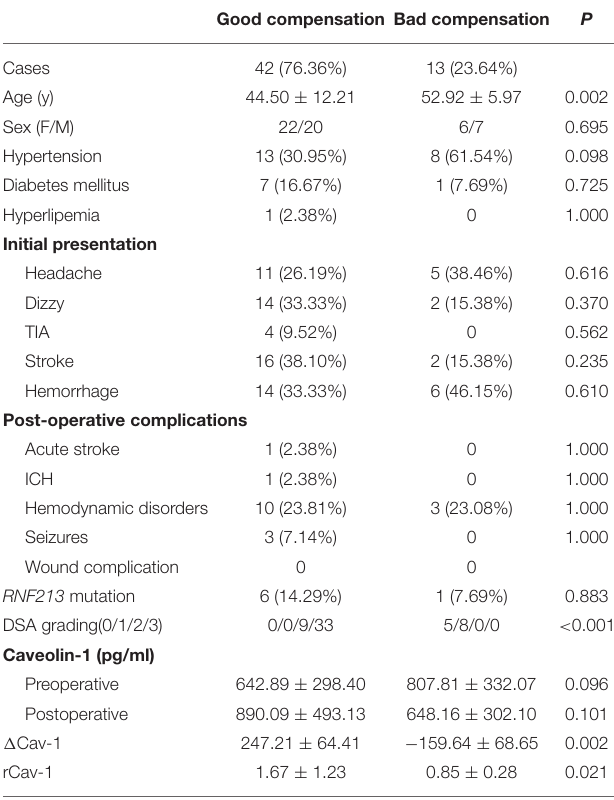
TABLE 2 | The clinical properties of 55 MMD patients with both preoperative and postoperative serum